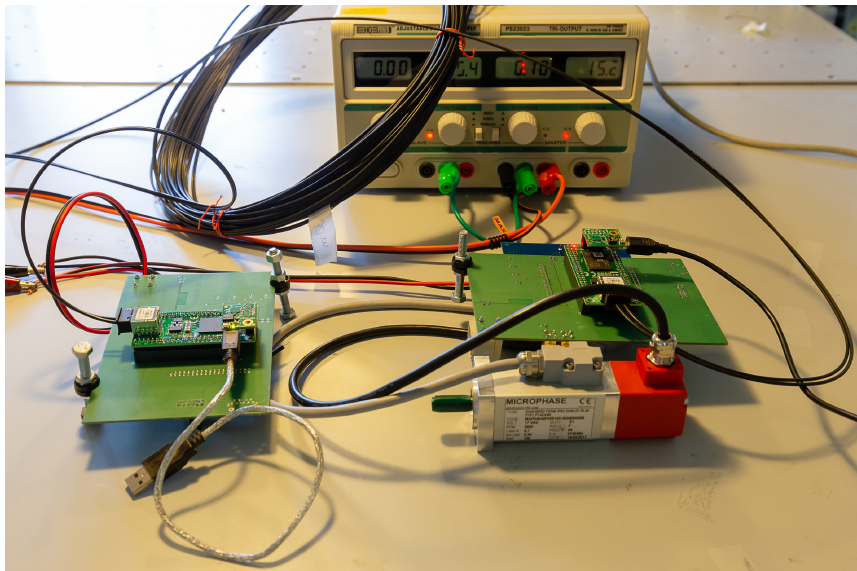
Figure 6. Demonstrator setup.